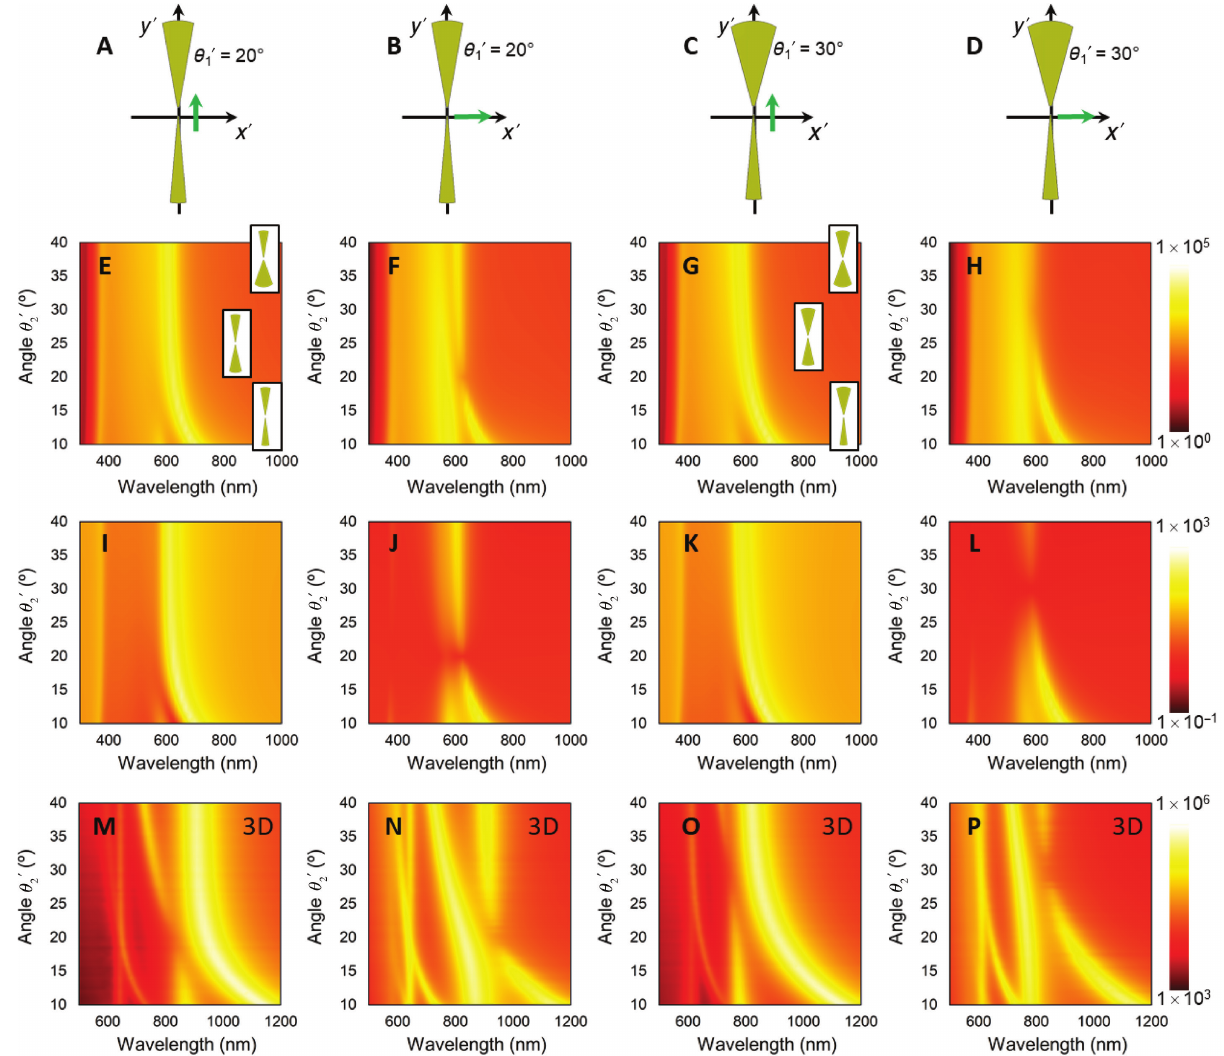
Figure 3: Non-radiative and radiative Purcell enhancement for asymmetric nanoantennas. The schematic representation of the l ′ = 20 nm and g ′ = 1 nm bowtie nanoantenna with θ ′ °= (A, C) and horizontal (B, D) nanoemitters; the nanoemitters are depicted by the green arrow. The corresponding Γ row) 2D bowties, and simulated Γ for a 1 nm-thick bowtie (bottom row). Insets in (E) and (G) depict the geometry of the bowtie for different θ ′ nr